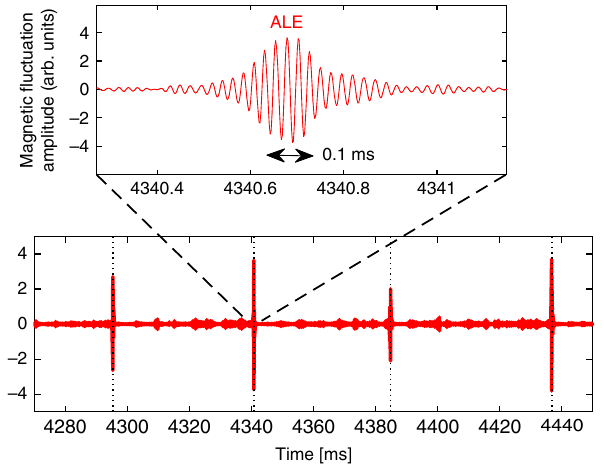
Fig. 1 Abrupt large-amplitude events in the JT-60U tokamak. This time trace of the magnetic fl uctuation amplitude in arbitrary units (arb. units) shows a sequence of four abrupt large-amplitude events (ALE) in JT-60U shot number E048424, which are visible here as large spikes that occur at intervals of 40 – 60 ms and last <0.3 ms each. The raw signal was measured with a sampling rate of 500 kHz using Mirnov pick-up coils that were located outside the plasma near the wall. Before plotting, the electric signal was time-integrated and band-pass fi ltered using a zero-phase forward and reverse digital Butterworth fi lter for the frequency range 30 – 70 kHz. An enlarged view of the second ALE is shown at the top, where one can see the rapid growth and decay of the Alfvénic oscillations with frequencies around 40 – 50 kHz. The time is measured in milliseconds (ms) relative to the start of the plasma discharge. The double arrow indicates a time interval of